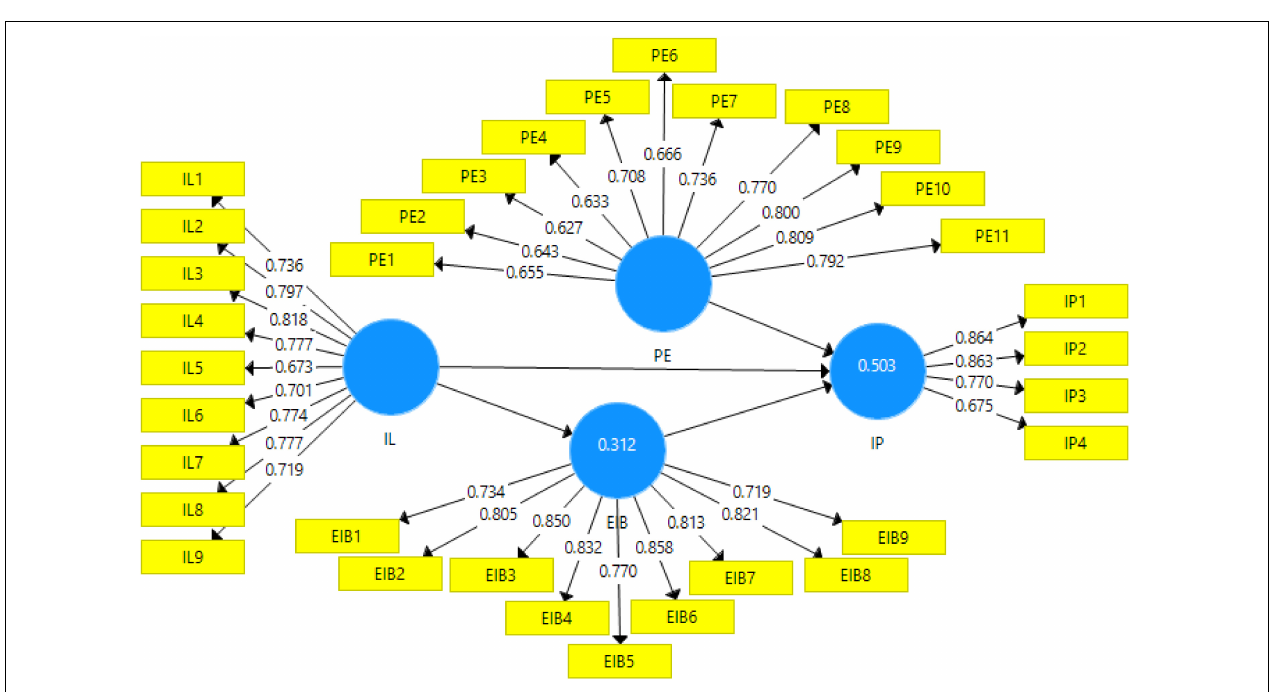
FIGURE 2 | Measurement model